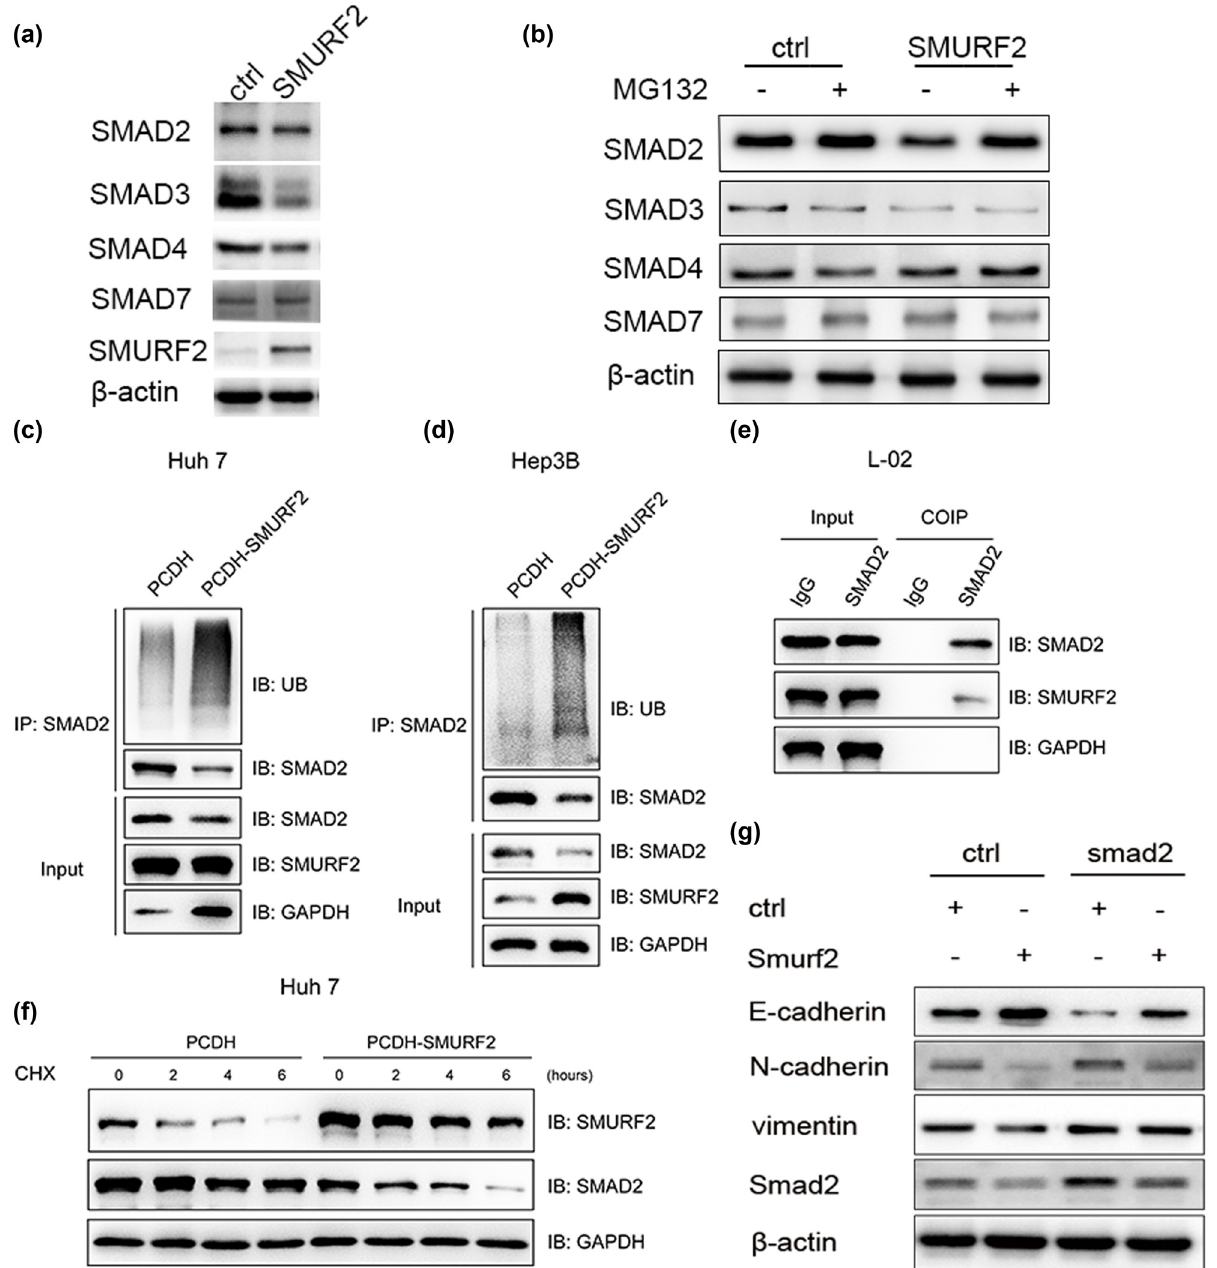
Figure 4: Smurf2 promoting the ubiquitination and degradation of Smad2. ( a ) The immunoblotting of Smurf2 and Smad2, Smad3, Smad4, and Smad7 protein levels in Huh7 - Smurf2 cells. ( b ) Smurf2 promoting the degradation of Smad2 through proteasome; Huh7 - Smurf2 cells treated with the proteasome inhibitor MG132 ( 2 µM ) for 8 h; the protein levels of Smad2, Smad3, Smad4, and Smad7; ( c and d ) Smurf2 promoting the ubiquitination of Smad2; huh7 and hep3B cells treated with PTCDH - Smurf2, immunoprecipitated with anti - Smad2 antibody and subjected to immunoblotting analysis using indicated antibodies. ( e ) Co - IP assay to verify the interaction between Smurf2 and Smad2 in L02 cells. ( f ) Huh7 cells, with or without Smurf2 overexpression, were treated with protein synthesis inhibitor CHX ( 100 µg/mL ) to block protein synthesis. immunoblotting was performed to detect Smad2 levels at di ff erent time points. ( g ) Smurf2 down - regulates the expression of Smad2 and inhibits EMT of HCC